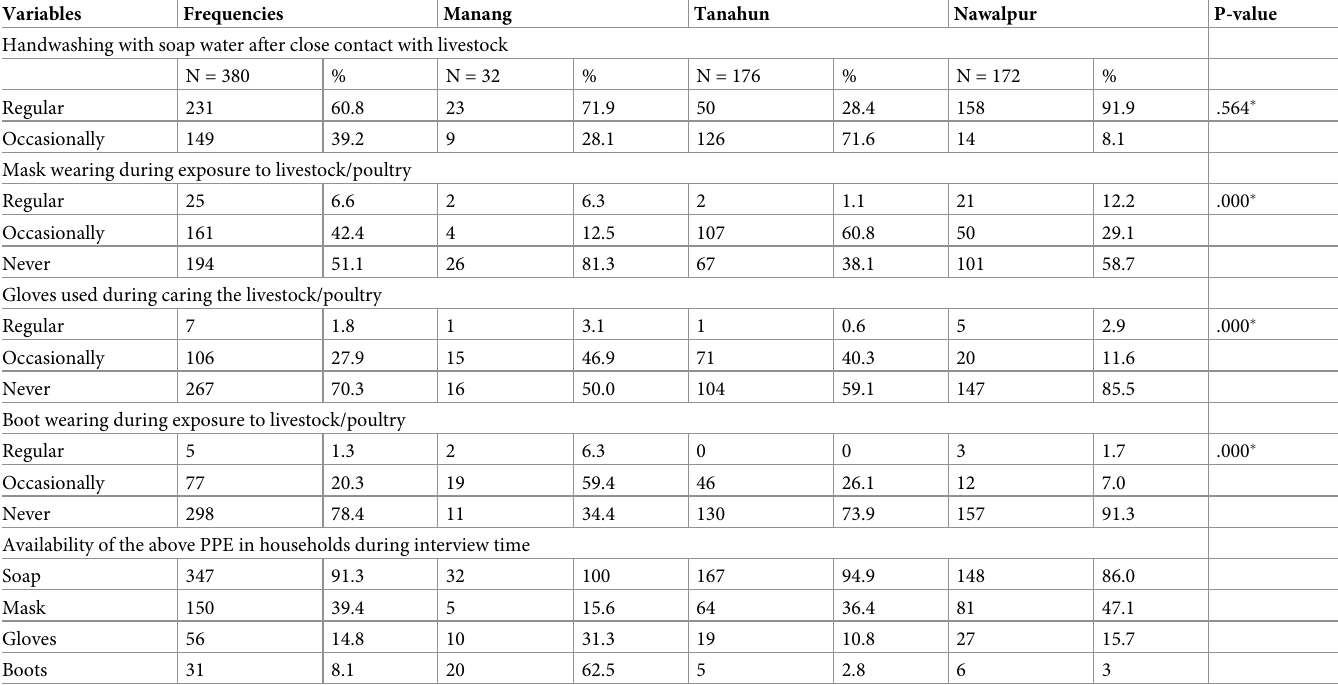
Table 5. Zoonoses preventive practices based on the ecological region of the